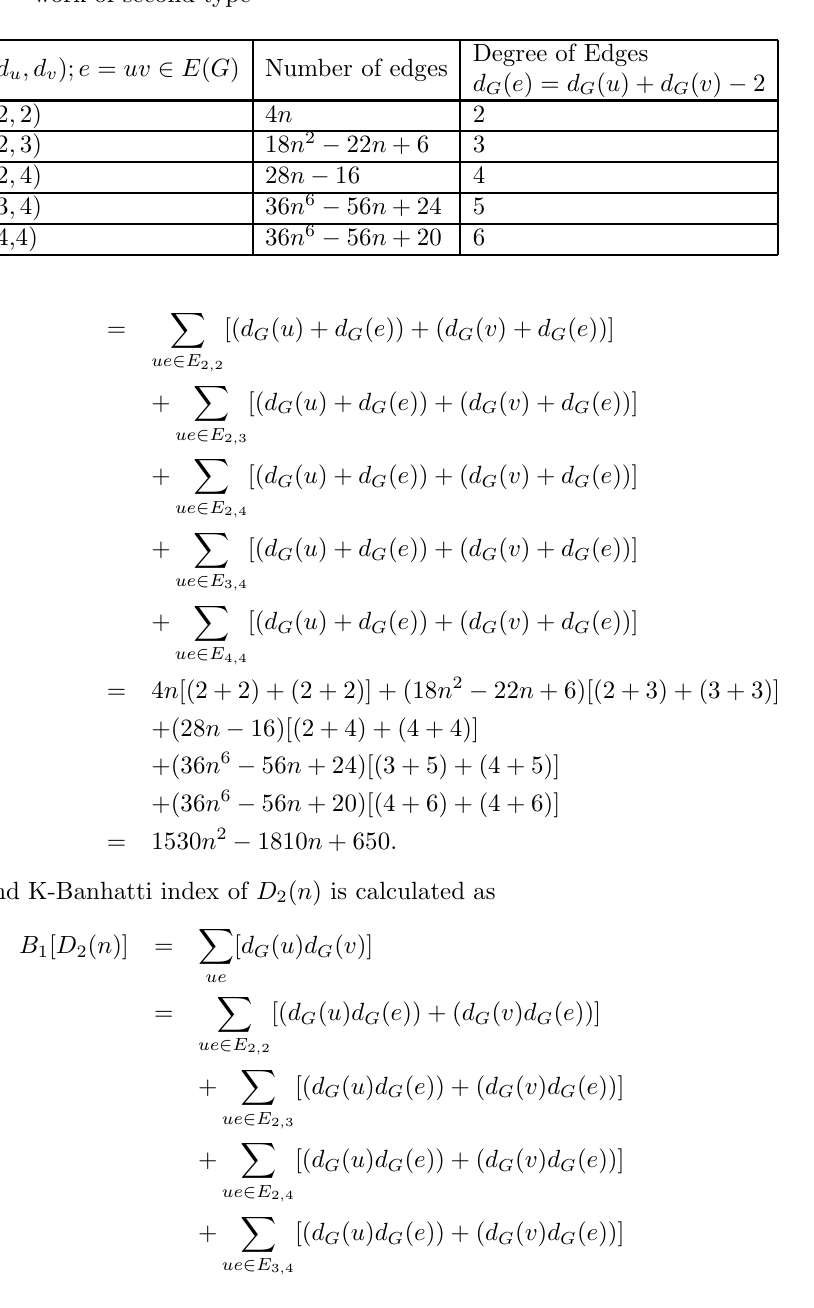
Table 2. Edge partition of Dominating David Derived Net- work of second